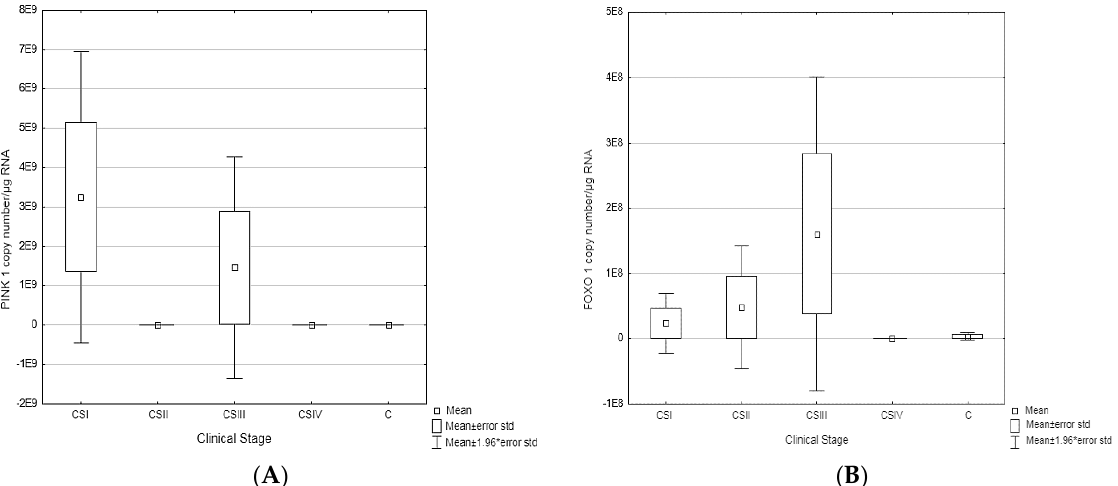
Figure 2. ( A ). Comparison of the number of PINK mRNA molecules in clinical stages (I–IV) of CRC vs controls (C). ( B ). Comparison of the number of FOXO mRNA molecules in clinical stages (I–IV) of CRC vs controls (C).